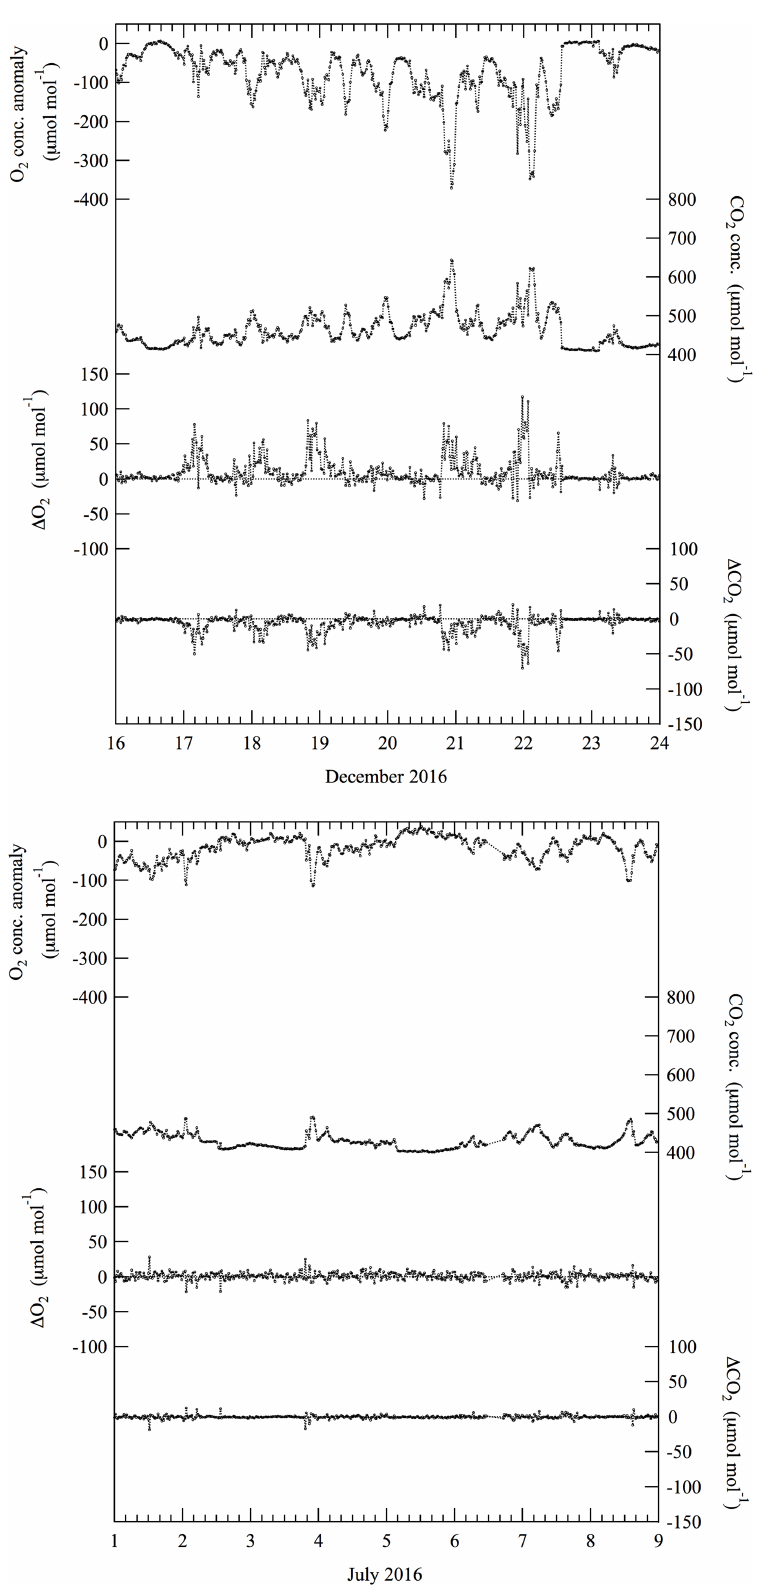
Figure 3. Same as in Fig. 2 but for O 2 and CO 2 concentrations, (cid:49) O 2 and (cid:49) CO 2 for the periods 16–23 December and 1–9 July